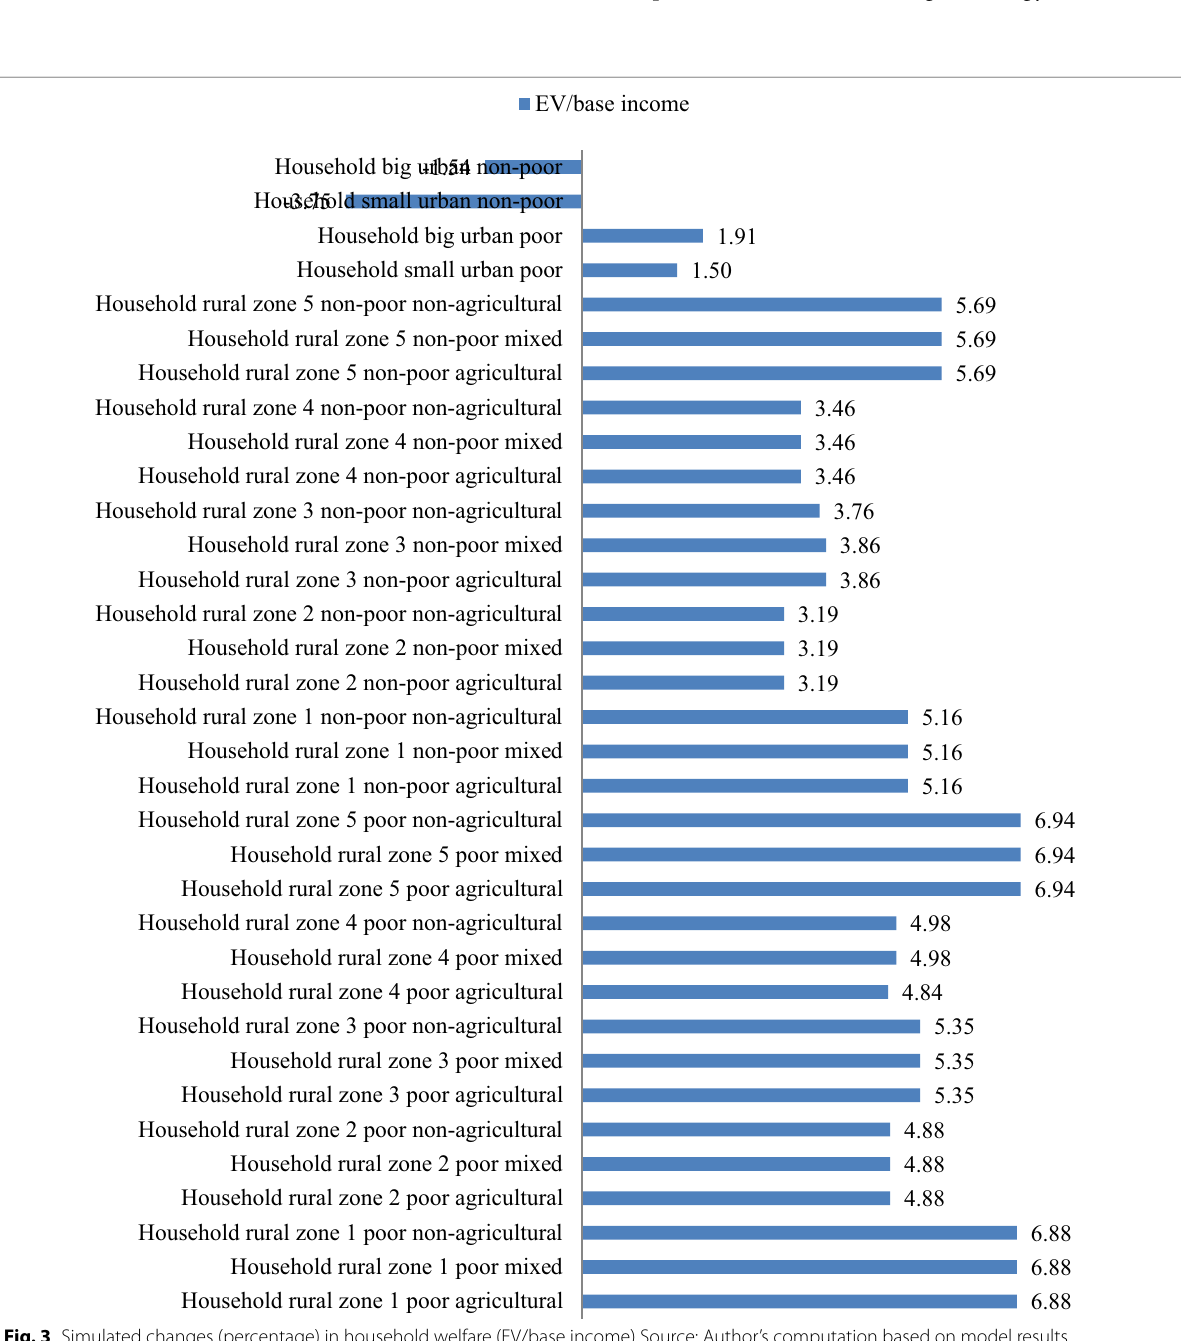
Fig. 3 Simulated changes (percentage) in household welfare (EV/base income) Source: Author’s computation based on model